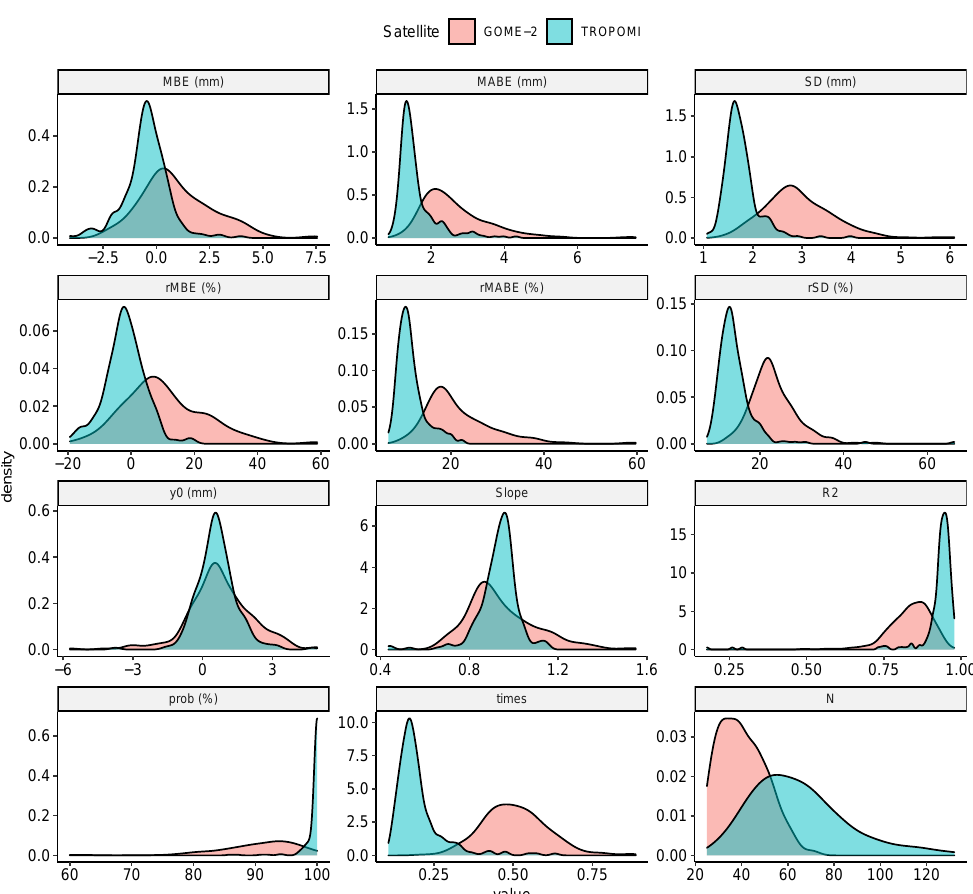
Figure 1. Statistical parameters for all stations. Values are given in mm for MBE, MABE, SD, y0; in percent for rMBE, rMABE, and rSD, while slope, R2 (correlation coefficient) and N (number of data) are unitless. Each value is calculated